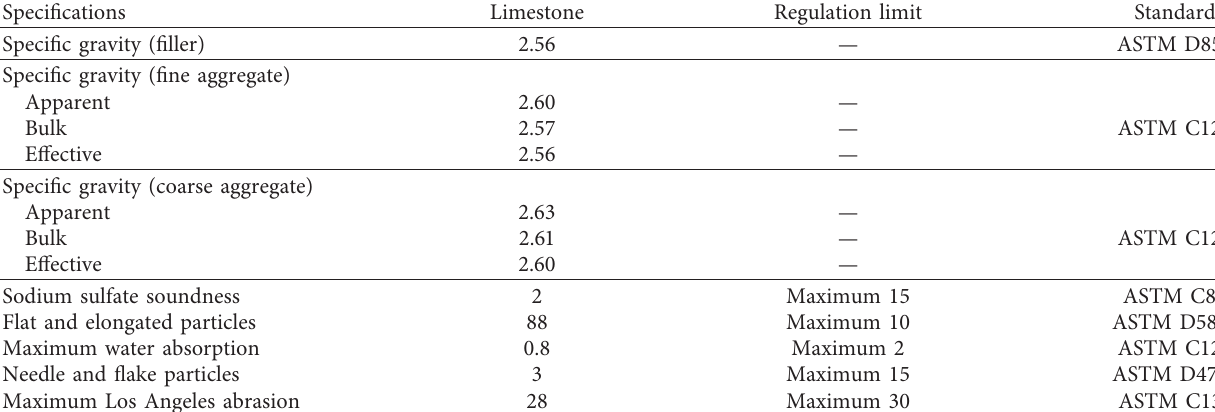
Figure 2: The gradation of aggregate used. Table 1: The physical specifications of